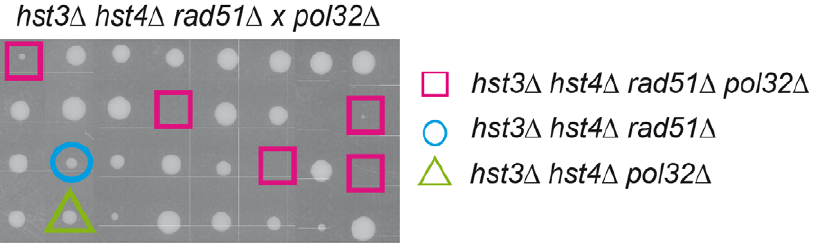
Figure 8. Inviability/synthetic growth defect of histone H3K56 deacetylation mutants in the absence of Rad51 and Pol32. Tetrad analysis of a rad51 D hst4 D hst3 D x pol32 D cross. Squares indicate quadruple mutants, which fail to grow.